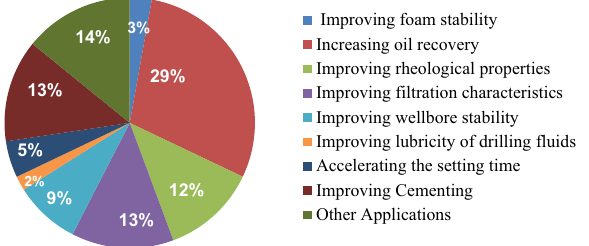
Fig. 3 Targeted property of improvement by means of NP